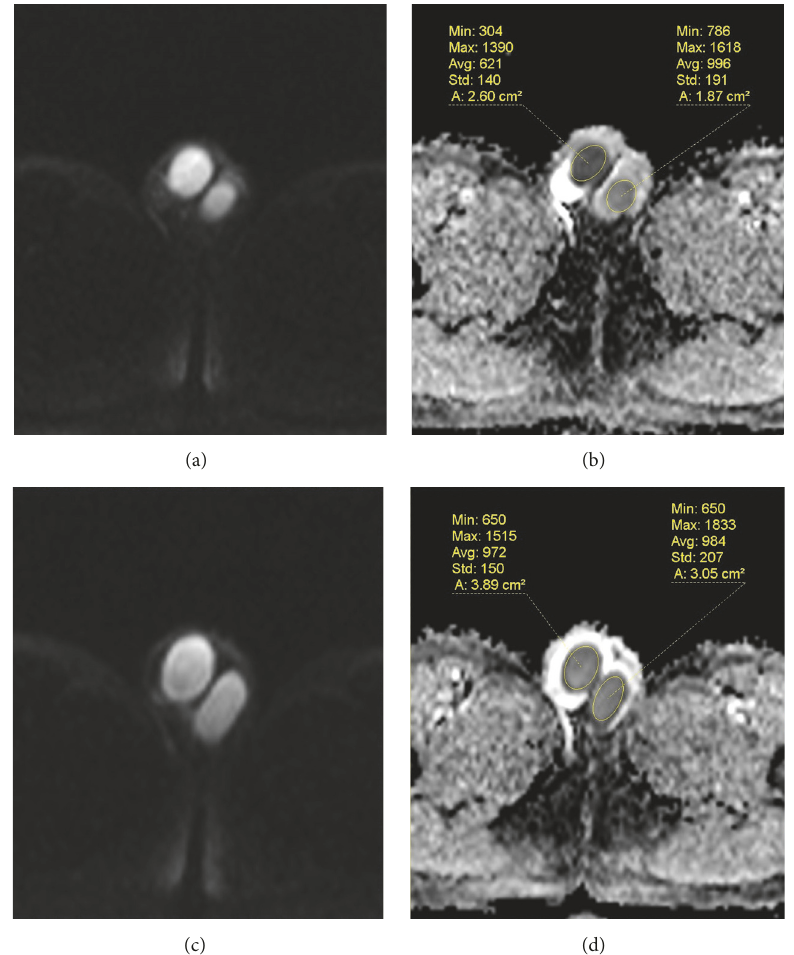
Figure 2: The right testicle shows high signal intensities on DWI (a). In the ADC map (b), the right testicle demonstrates lower ADC value than the left testicle. On DWI (c) and ADC map (d) obtained half an hour later following the preoperative external detorsion procedure, an isointense right testicle relative to the unaffected left testicle appears, which reflects the restoration of parenchymal blood